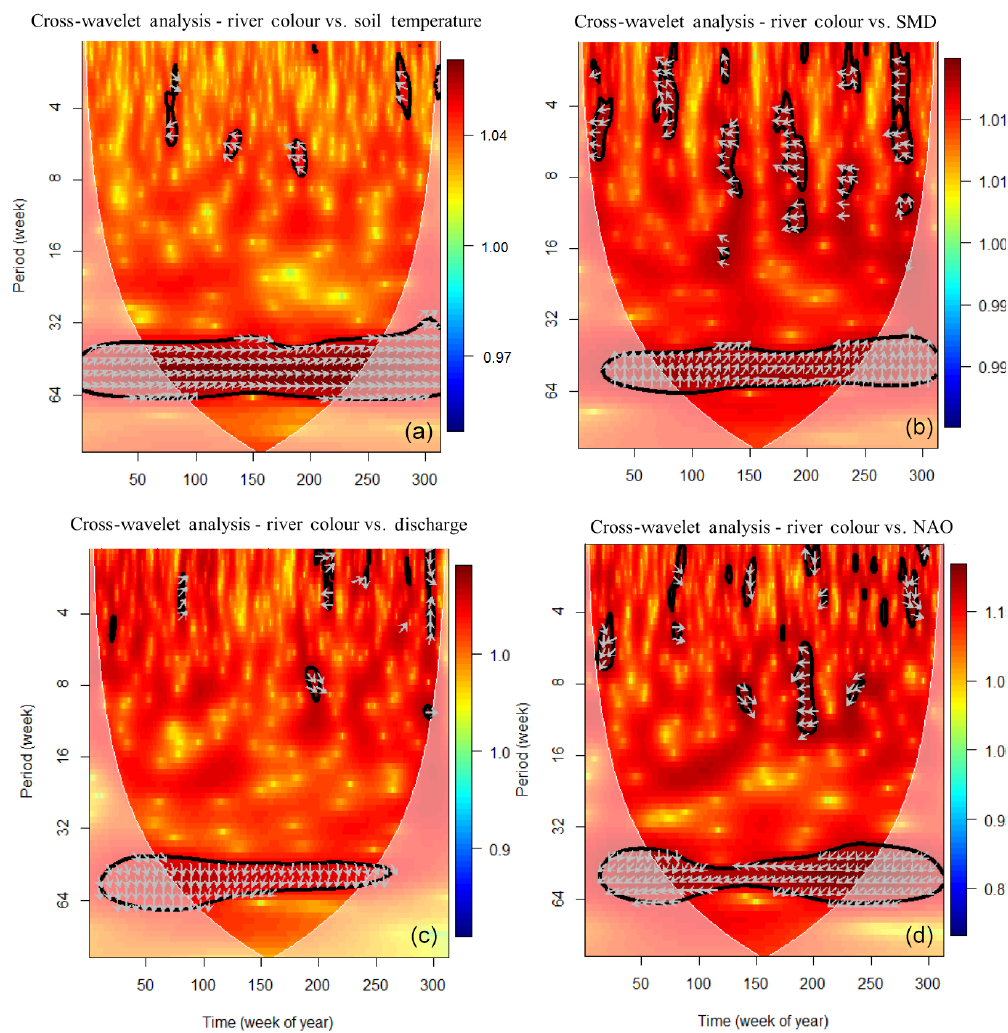
Figure 6. Cross-wavelet power spectrum of soil temperature at 1m depth ( a ), soil moisture deficit (SMD) ( b ), river discharge in the Glena- mong ( c ) and NAO ( d ) with river colour. Colour contours represent cross-wavelet power, and vectors indicate the relative phase relationship between the two time series (with in-phase pointing right, anti-phase pointing left, or a variable leading or following river colour by 90 ◦ pointing straight down or up). The 5% significance level is shown as a thick contour. Pink regions on either end indicate areas where the analysis is unreliable as there are no data before and after the study